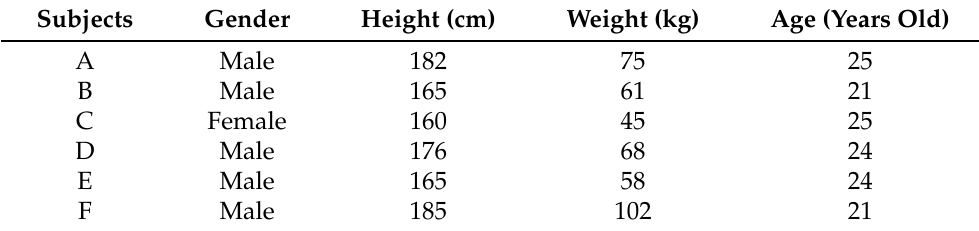
Table 2. The physical conditions of subjects.